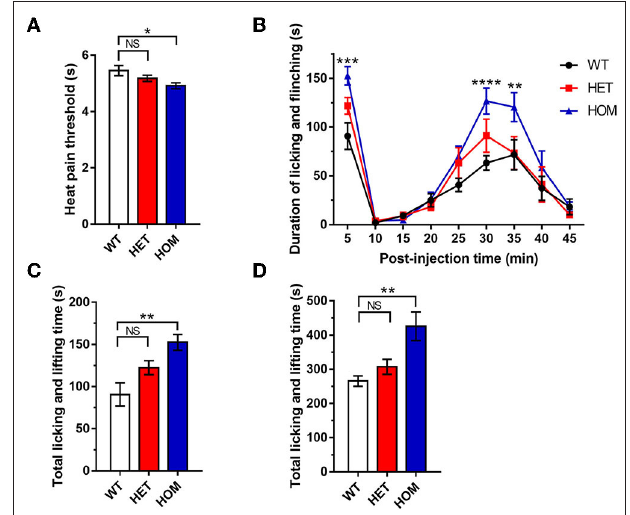
FIGURE 1 | Somatic pain threshold comparison. (A) Hargreaves’ test. Paw withdrawal latency was recorded using a radiant light heat source to heat